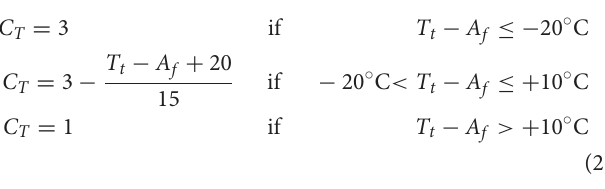
Lastly, a correction factor (C t ) based on the austenite finish temperature (A f ) determined with Differential Scanning Calorimetry (PF: 50.23 ◦ C; VB: 37.09 ◦ C, Y. Gao,